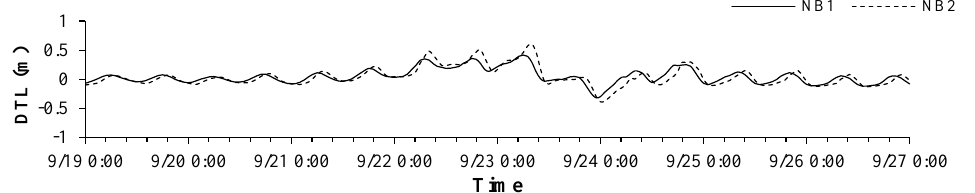
Figure 15. Time history of difference in tidal level (DTL) between the two scenarios of Typhoon Fongwong and normal wind force action at NB1 and NB2 in the NB in 2014.4.